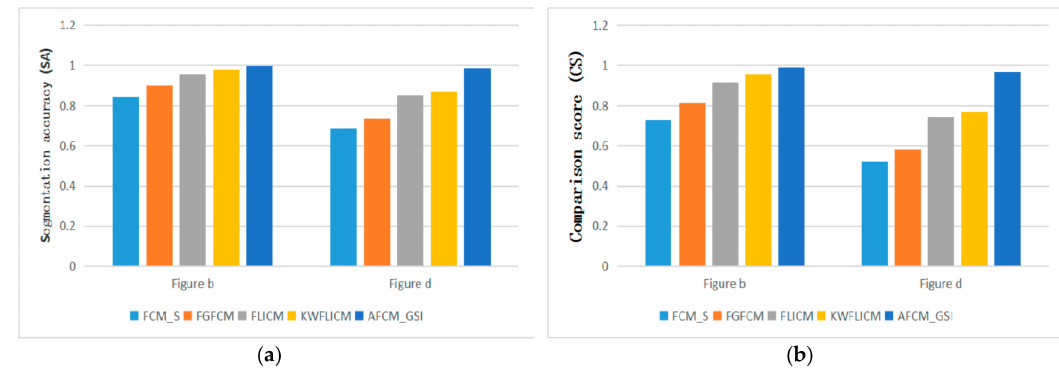
Figure 4. SA and CS of five algorithms on noisy synthetic image 1 and 2.